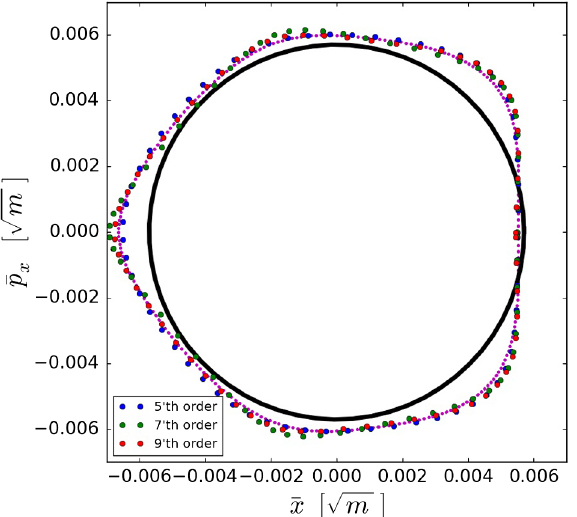
FIG. 6. The Δ θ after one turn calculated from tracking (dotted line), and from Re ϕ þ Im Δ = 2 (solid line) for various initial FIG. 4. Curveswithconstant j w at fifth,seventh,andninthorder x j x ¼ 8 , 12, 16, 20, 24 (blue,green,red)inphasespacecomparedwiththeresultoftracking 512 turns and the circle passing through the initial point (black).